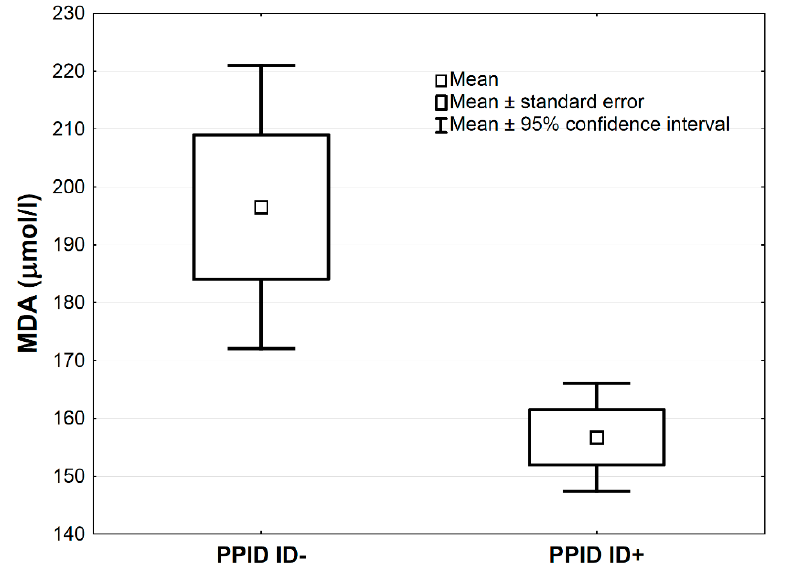
Figure 4. Mean values of LPS activity measured in serum of horses in PPID ID+ and PPID ID − group. Statistical significance was set at p < 0.01.